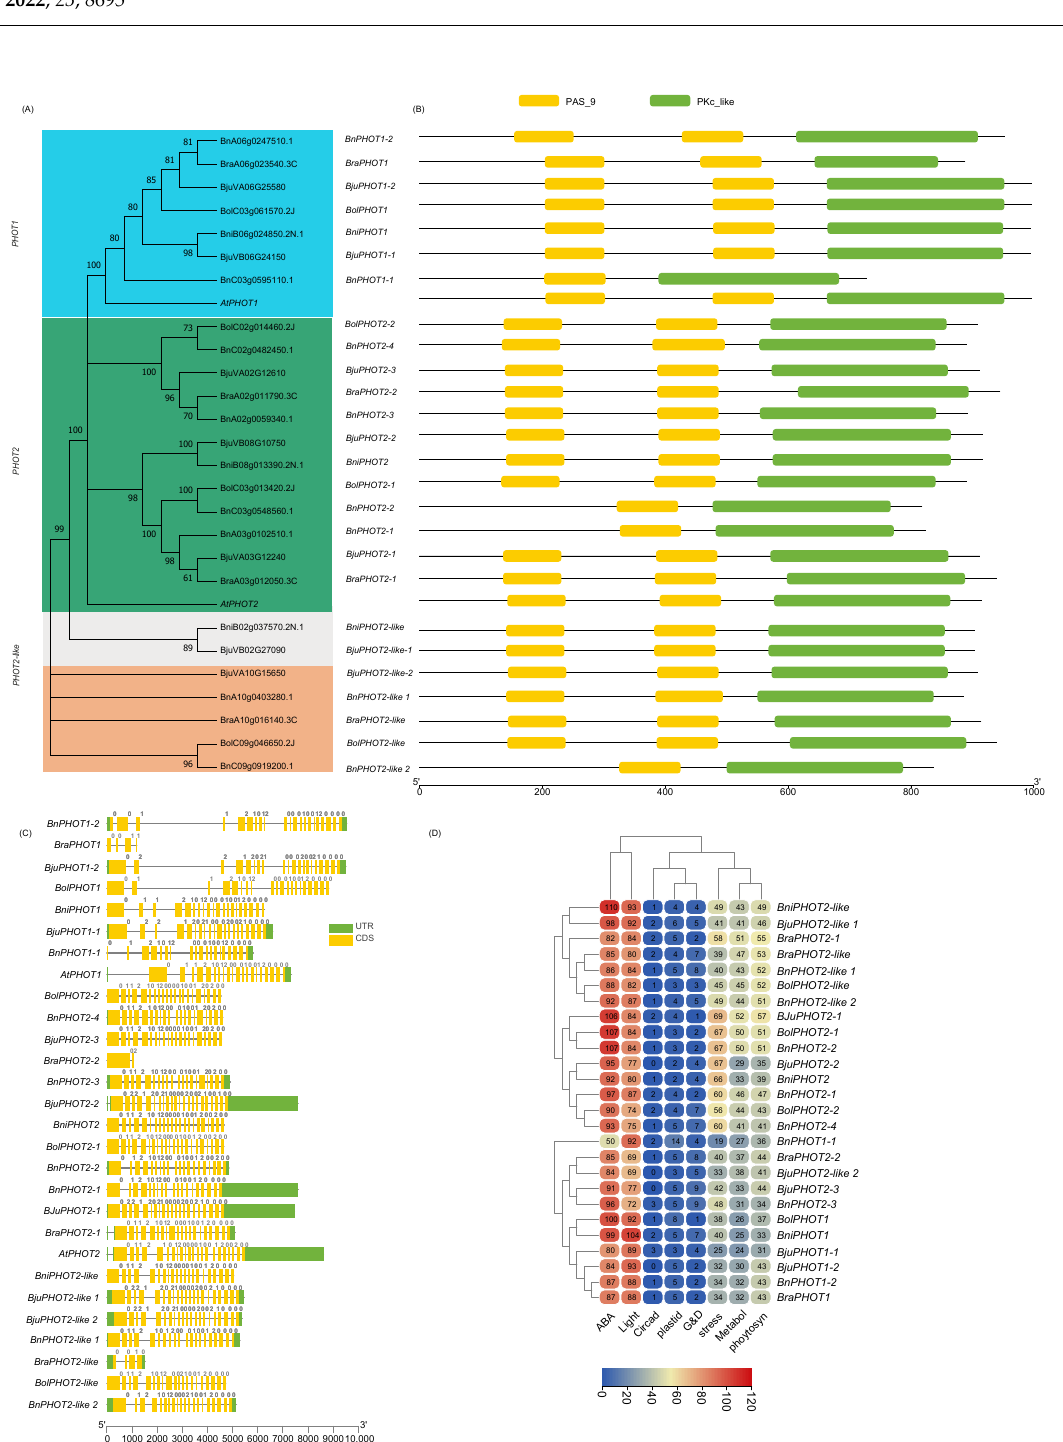
Figure 3. Phylogenetic analysis, classification, and structural description of phototropin (PHOT) gene family in Brassica species. ( A ) The unrooted phylogenetic tree was established with Arabidopsis and five Brassica species ( B. rapa , B. oleracea, B. nigra , B. napus , and B. juncea ) PHOT protein sequences using the neighbor-joining tree method with 1500 bootstrap replications in MEGA11. ( B ) Repre- sents the domain architecture of phylogenetically classified PHOT genes of Brassica species, while ( C ) represents the gene structures including Intron/exon pattern and intron phases (Class 0, 1, and 2) and UTRs. ( D ) Heatmap represents the key cis-regulatory elements (ABA- and light-responsive, elements associated with plastids, circadian rhythm, growth and development (G&D), stress, metabo- lite biosynthesis, and photosynthesis) and their abundance in putative promoter motifs of Brassica PHOT genes reported in this